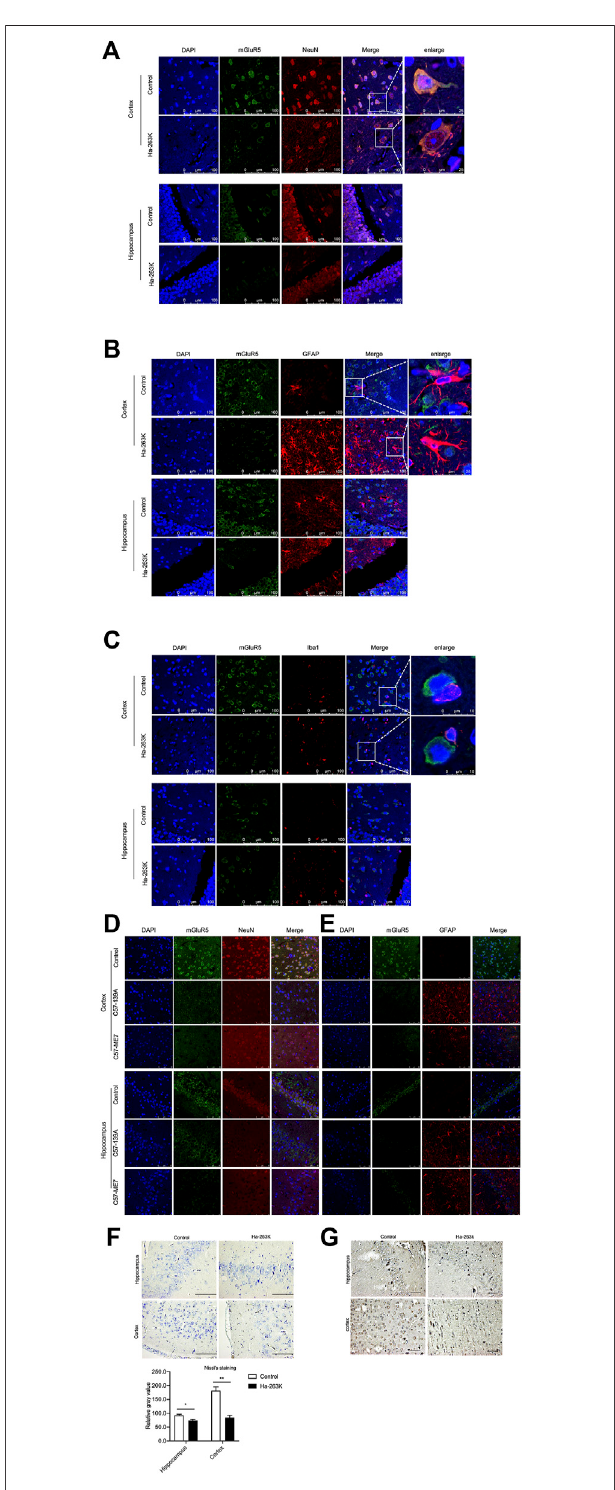
FIGURE 9 | Immuno fl uorescent staining of mGluR5 in cortex and hippocampusslicesofprion-infectedrodentmodels. (A-C) Double-stainingof mGluR5 with NeuN (A) , GFAP (B) and Iba1 (C) in cortex and hippocampus slices of 263 K-infected hamsters. (D-E) Double-staining of mGluR5 with NeuN (D) and GFAP (E) in cortex and hippocampus slices of 139 A-